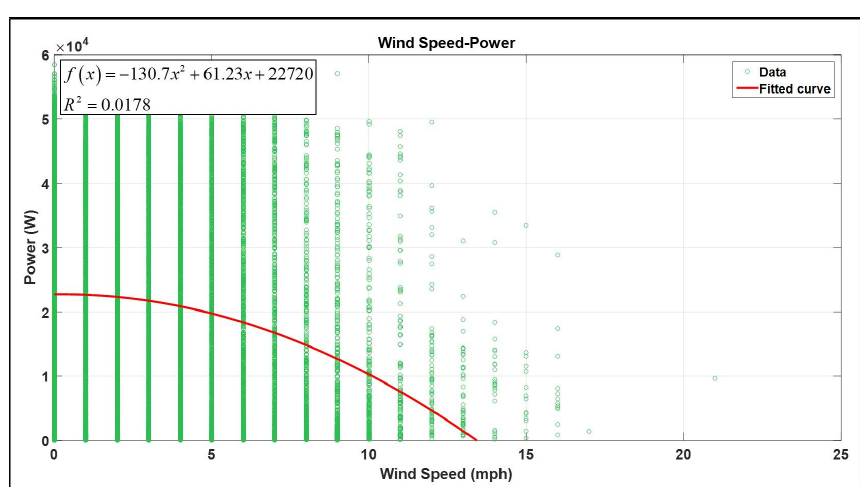
Figure 13. The Power vs. Wind speed of MCS.